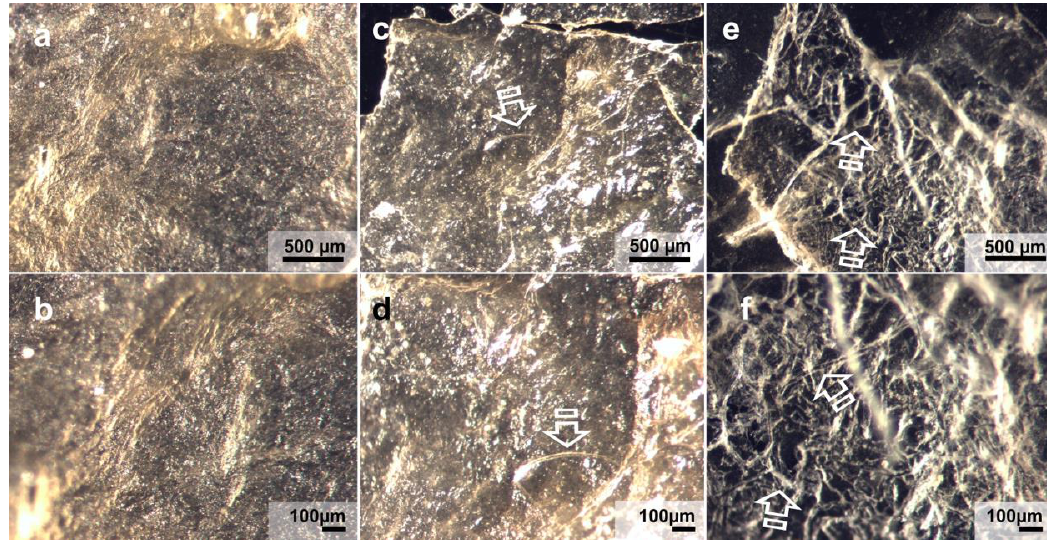
Figure 5. Light micrographs taken from matrices after Trypsin degradation assay after 7 days of storage. ( a ) Fibro-Gide surface at 60× magnification. ( b ) Fibro-Gide surface at 120× magnification. ( c ) Mucograft surface at 60× magnification. ( d ) Mucograft surface at 120× magnification. ( e ) Mucoderm surface at 60× magnification. ( f ) Mucoderm surface at 120× magnification. Scale bar is 500 µm in ( a – c ), and 100 µm in ( d – f ). Disorganized fiber structure caused by partial degradation with rippled collagen fibrils (arrows) is observed.